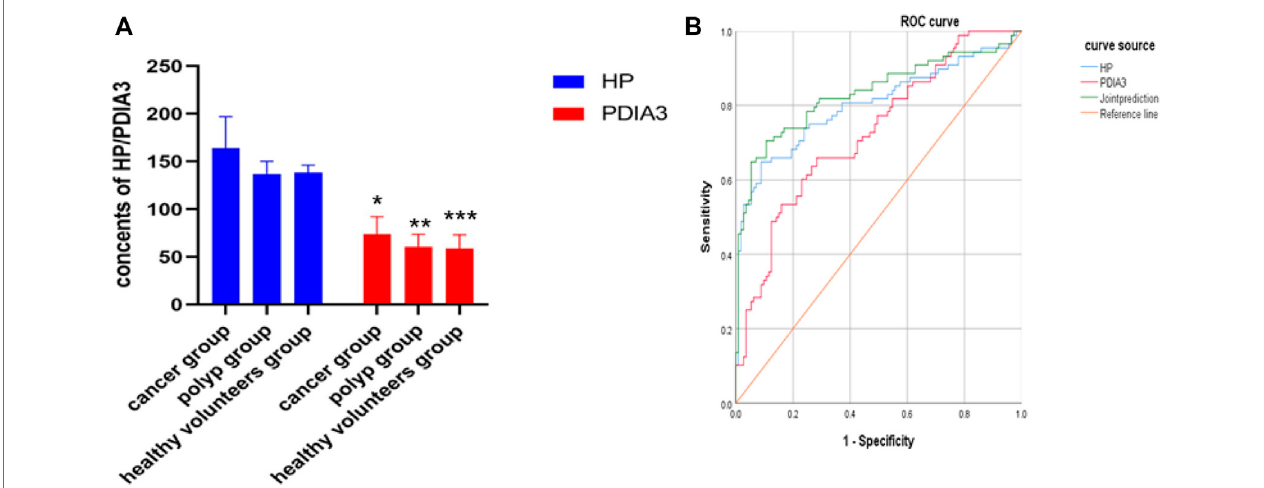
FIGURE3| ContentsofHPand PDIA3ineach groupand ROCcurve inwhichserum levelsofHPandPDIA3indicatingcolorectal cancer. (A) .Inthecancergroup, the average contents of HP and PDIA3 are 164 ± 33 μ l/ml and 74 ± 18 ng/ml. In the polyp group, the average contents of HP and PDIA3 are 137 ± 13 μ l/ml and 61 ± 13 ng/ml. In the healthy volunteers group, the average contents of HPand PDIA3 are 138 ± 8 μ l/ml and 58± 15 ng/ml( p < 0.05). (B) . Diagnostic value of HPand PDIA3 for colorectal cancer. *vs. cancer group ( p < 0.05), **vs. means polyp group ( p < 0.05), *** vs. healthy volunteers group ( p < 0.05).